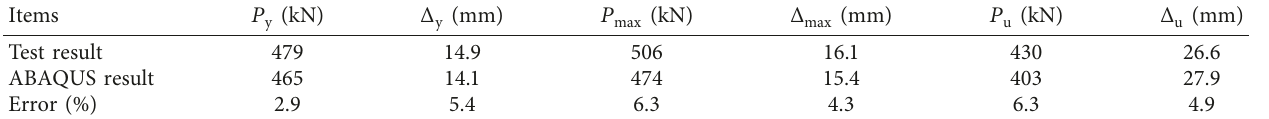
Table 6: Comparison of the finite element analysis and experimental results of specimen C-JB.